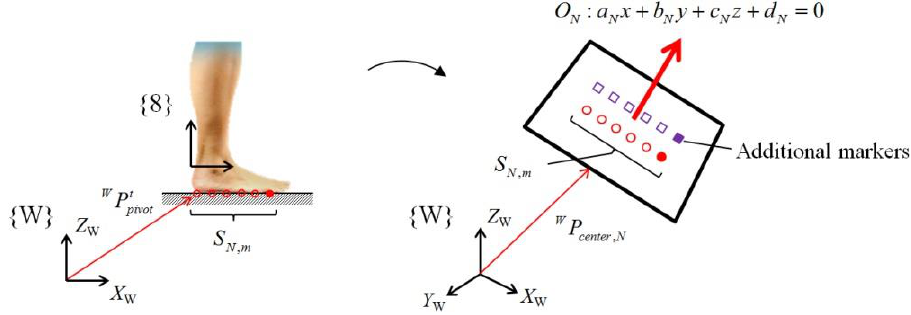
Figure 17. Modelling of the walking ground as a plane using the collected pivot points of each step. Because the markers were continuously collected while the foot of the exoskeleton remained in contact with the ground, the size of the marker set increased during the contact. Therefore, the plane of the ground for each step also changed as the set was updated. Figure 18 shows that the transitions of the plane equation components ( a N , b N ) are continuously updated for one gait cycle during walking. Therefore, the longer the contact with the ground, the closer the modeled plane will be to the actual